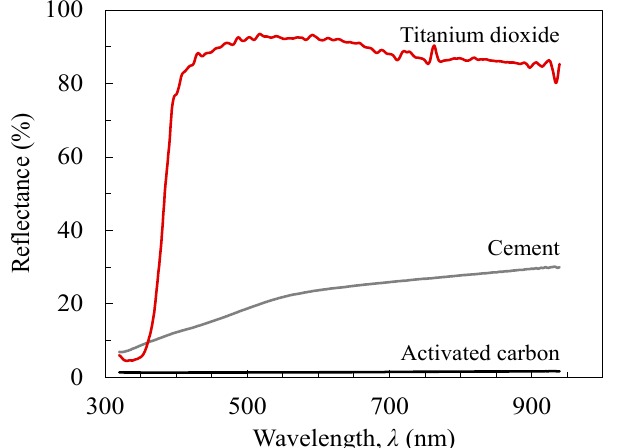
Figure 6. Reflectance curves of the raw materials (titanium dioxide, Portland cement, and activated carbon).